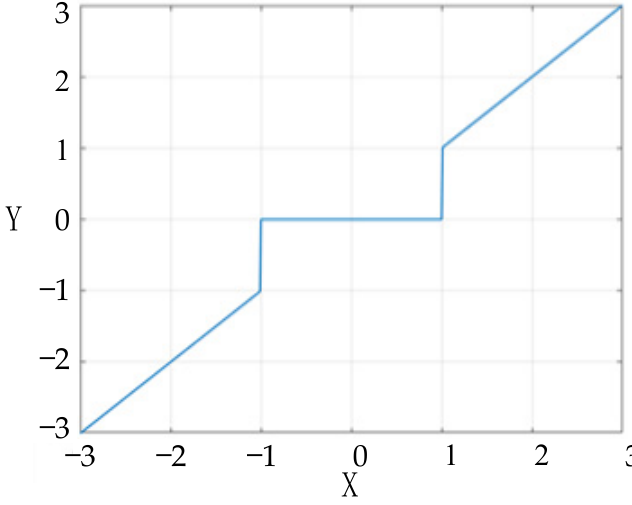
Figure 1. Hard threshold denoising.